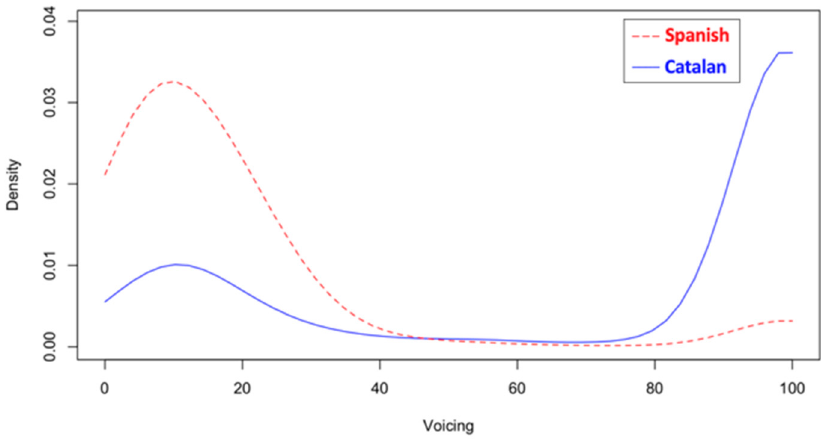
Figure 5. Kernel density plot of Catalan and Spanish intervocalic fricative voicing proportions.